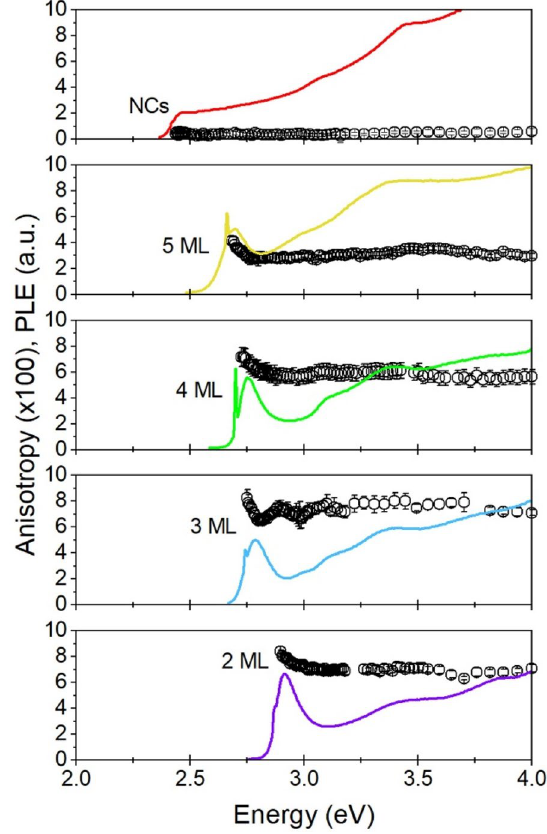
Fig. 3 Photoluminescence excitation scans (solid lines, arbitrary scale) and energy-dependent fluorescence anisotropy (open circles). Each data point represents the calculated fluorescence anisotropy of at least 3 measurements measured with an excitation energy of the data point. Anisotropy values are shown scaled ( × 100), but the same scale is used for each